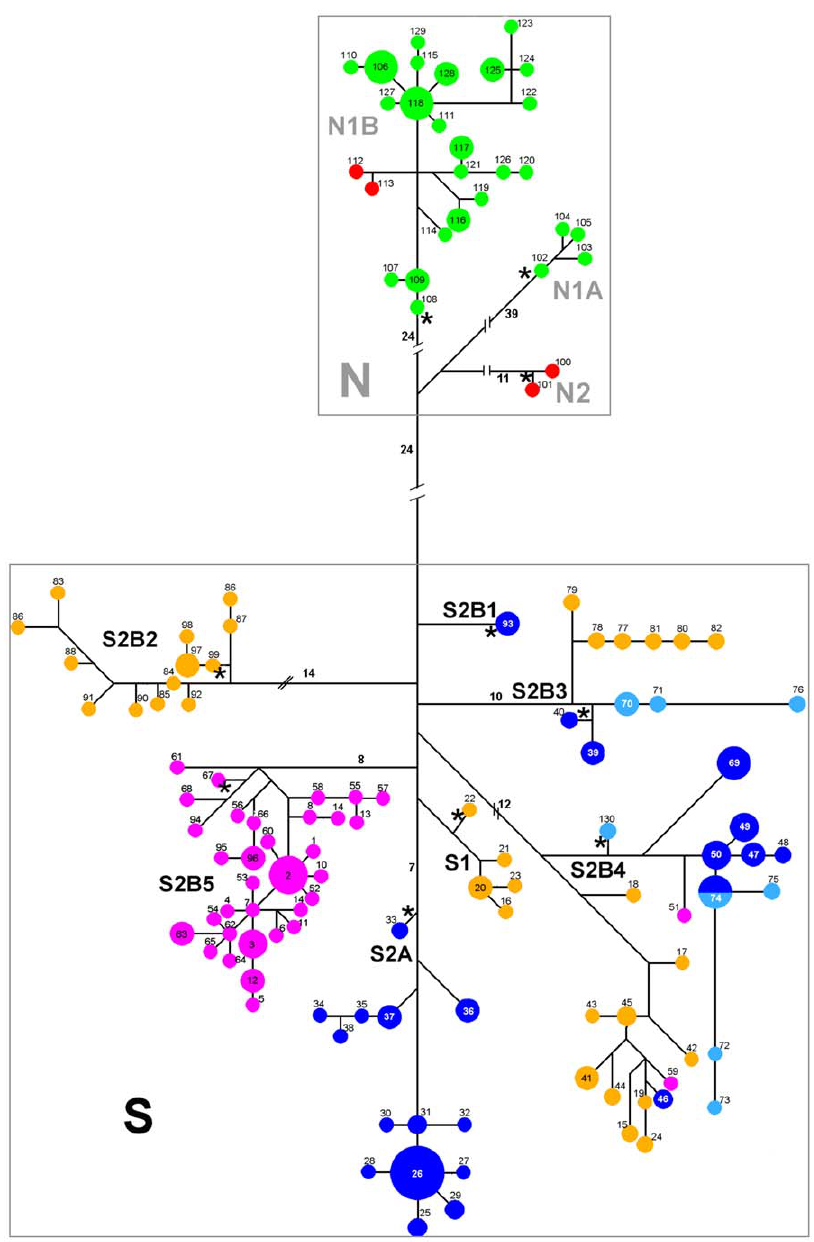
Figure 3. Cyt-b haplotype network for L.pictus . Colors are the same as in Fig. 1, probable ancestral haplotypes for each haplogroup are labeled with asterisks, and numbers on the lines correspond to mutation